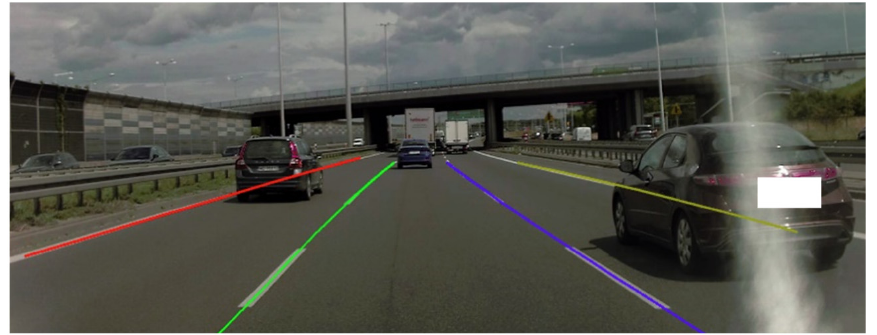
Figure 3. Part of the research: lane and road edge detection by the AV’s perception system ( Ł ukasiewicz Research Network—Automotive Industry Institute).